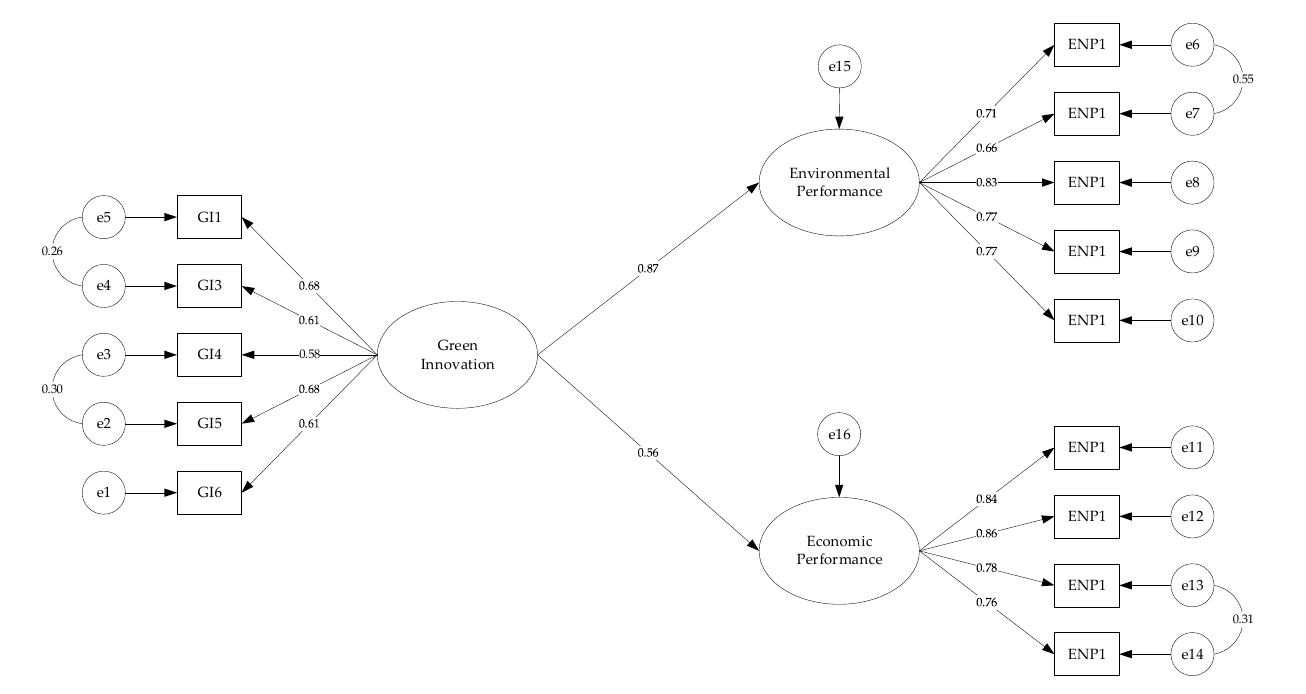
Figure 2. Structural equation model. Table 5. SEM model fit indices.